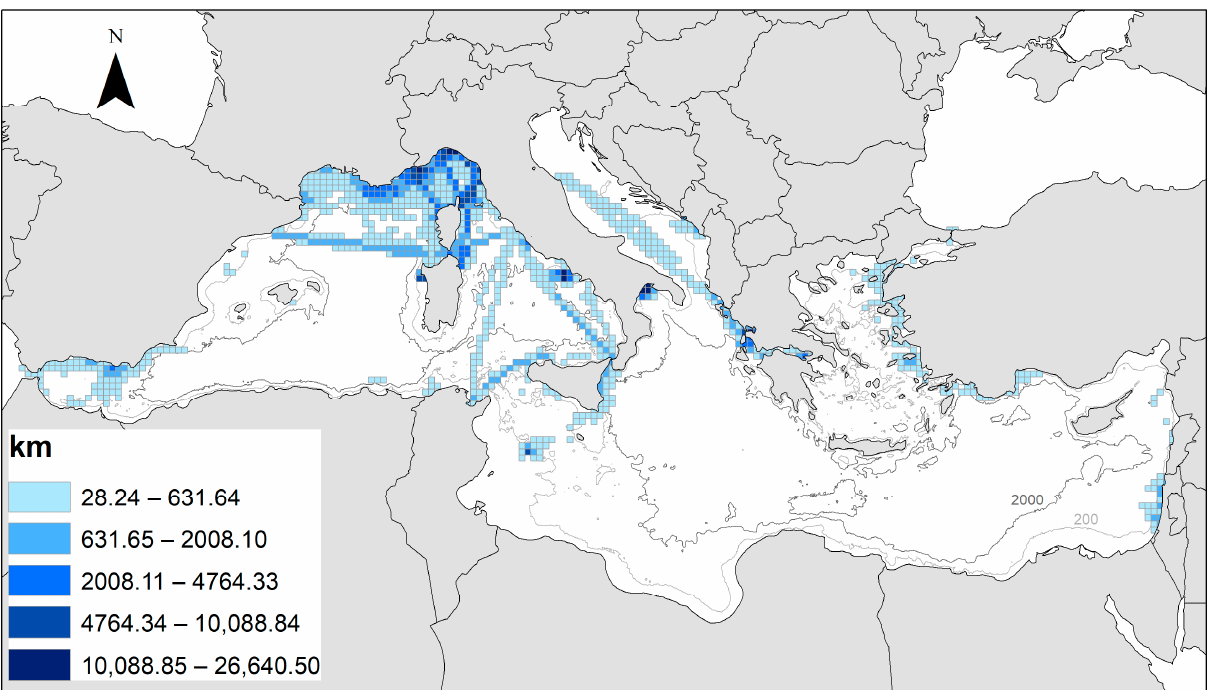
Figure 3. The sampling effort (km) performed by the research units per sampling cell (20 × 20 km).